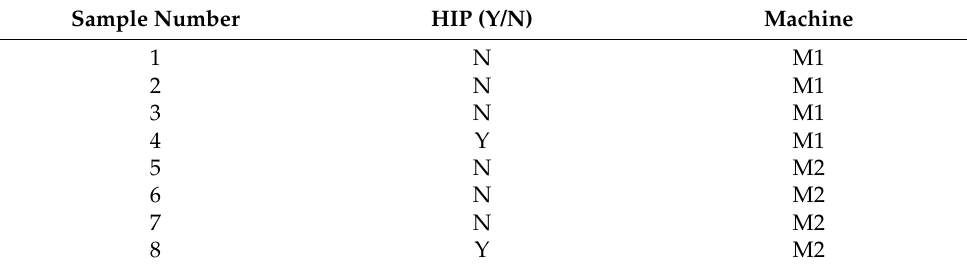
Table 1. Details of the Inconel 718 SLM samples produced for this